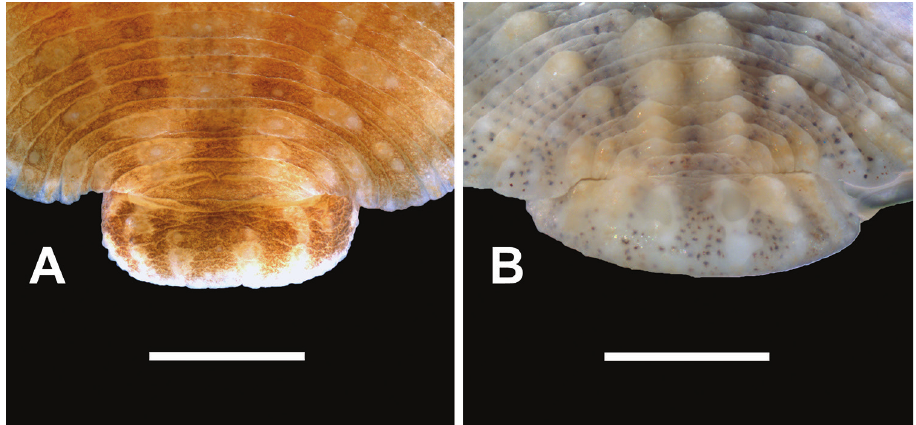
Figure 5. Dorsal surface, anal region, (note lack of papillae between anus and commencement of promi- nent paramedial papillae) of A Placobdella papillifera (YPM IZ 083792) B Placobdella siddalli Richardson & Moser (YPM IZ 083857). Scale bars: 1